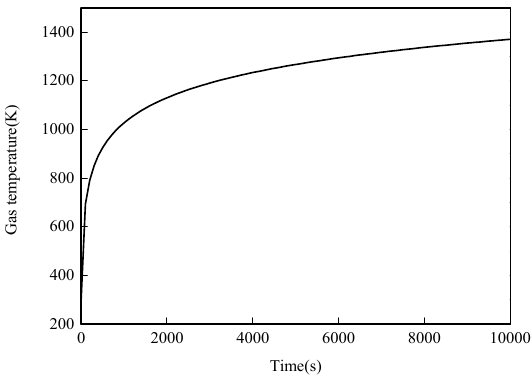
Figure 11. Boundary conditions of the numerical model.